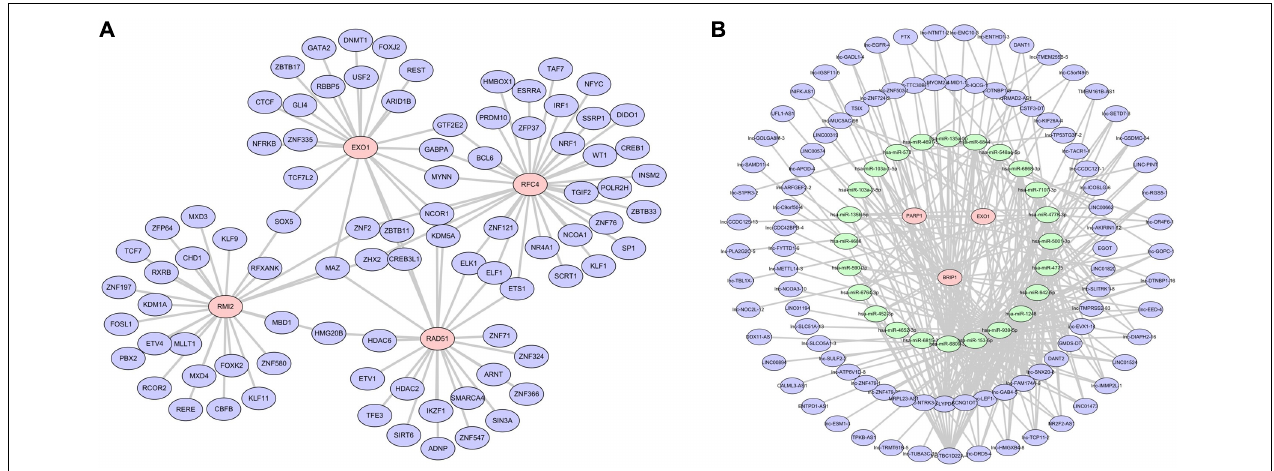
FIGURE 10 | Regulatory network of the risk model genes. (A) Transcription factor regulation network diagram. Only four of the six model genes ( RAD51 , EXO1 , RMI2, and RFC4 ) predicted the corresponding transcription factors. In the picture, red is the model gene and blue is TF. (B) Transcription factor regulation network diagram. In the picture, red is the model gene, green is miRNA, and blue is lncRNA. Three model genes, 25 miRNAs, and 94 lncRNAs were screened